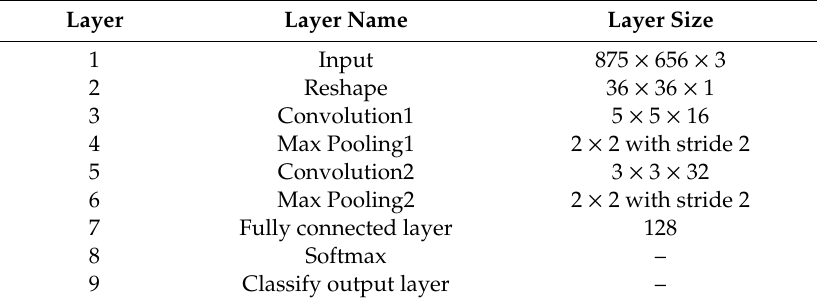
Figure 17. Validation accuracy at different ratios. Table 3. Architect of